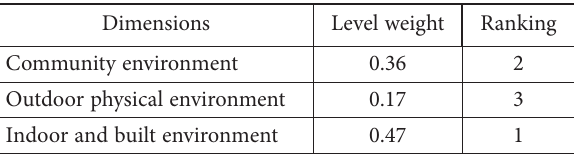
Table 3. First level weights and